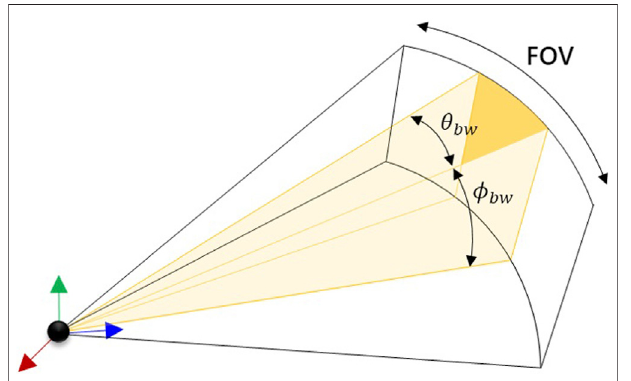
FIGURE 2 | Set of rays forming a single sonar beam.